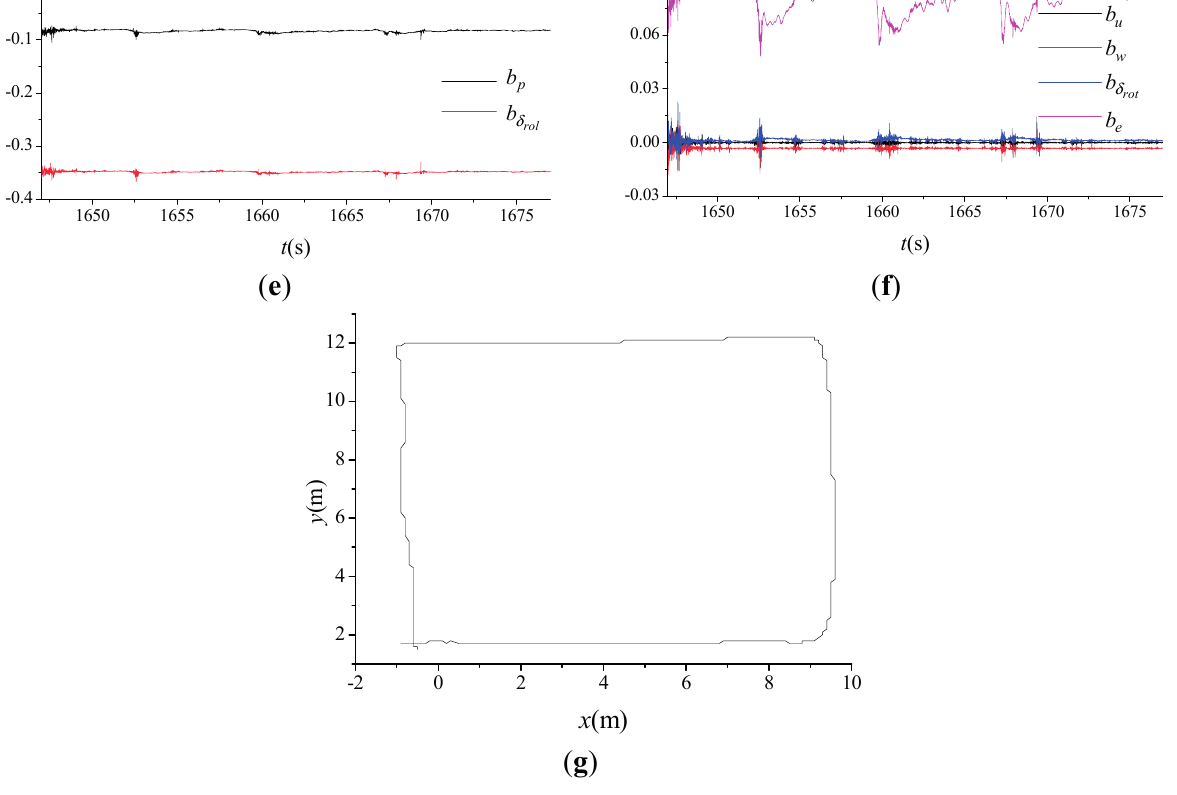
q and q ; ( c ) e ; ( d ); m